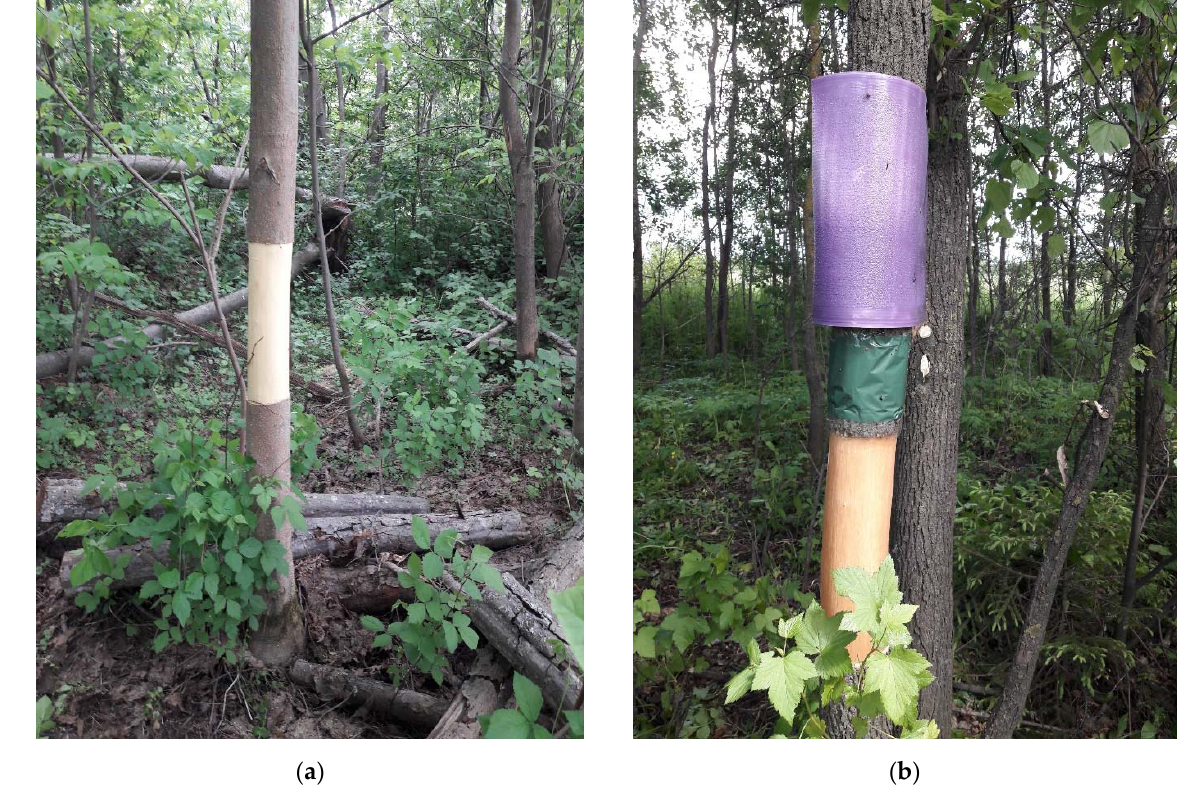
Figure 2. ( a ) A girdled F. pennsylvanica tree (50 cm of the bark removed at the height of 1.0–1.5 m); ( b ) two sticky trapping sheets attached above the section of the removed bark: below—a 14 cm-wide dark-green sticky belt; above—a 35 cm × 60 cm purple sticky prism trapping sheets made of colored corrugated plastic. Photo by D. L. Musolin. Table 1. Locations of the study plots, characteristics of girdled Fraxinus pennsylvanica trees, and results of regular exami- nations (September 2018–October 2019). No. of No. Location